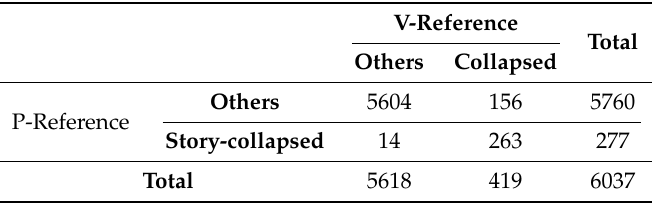
Table 2. Comparison of the two reference datasets.